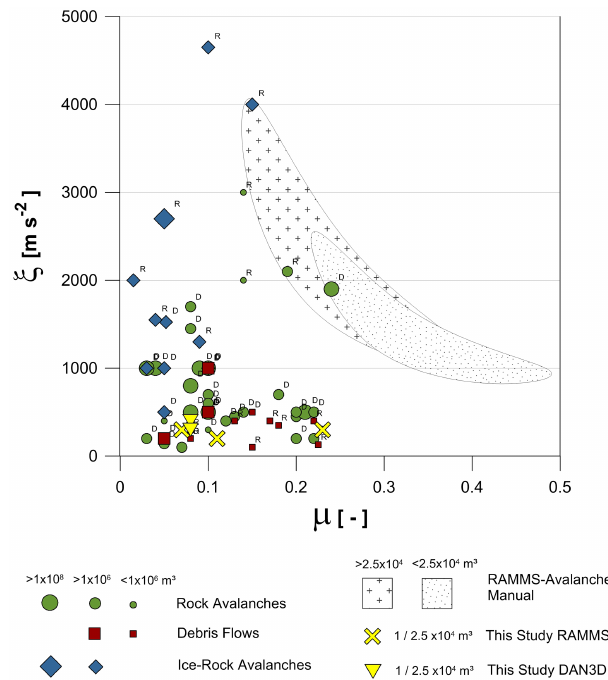
Figure 7. Voellmy resistance parameter sets from back-calculation of different events with RAMMS ( R ) and DAN(3D) ( D ). Debris- flow parameters from our study are presented as yellow crosses and triangles, respectively. Debris-flow parameters from other studies (Scheidl et al., 2013; McDougall et al., 2006; Hungr et al., 2002; Hungr, 2008b; Bartelt et al., 2013b; Jakob et al., 2000), are given as brown squares. Rock avalanches are illustrated as green circles and ice-rock avalanches are denoted by blue diamonds (Pirulli et al., 2004; Hungr and Evans, 1996, 2004; Hungr and McDougall, 2009; Hungr, 2008b; Evans et al., 2007; Allen et al., 2009; Sosio et al., 2008; Lipovsky et al., 2008; Schneider et al., 2010). Suggested parameter ranges for small ( < 25000m 3 ) and large ( > 25000m 3 ) snow avalanches are given in two different shaded areas (Bartelt et al.,